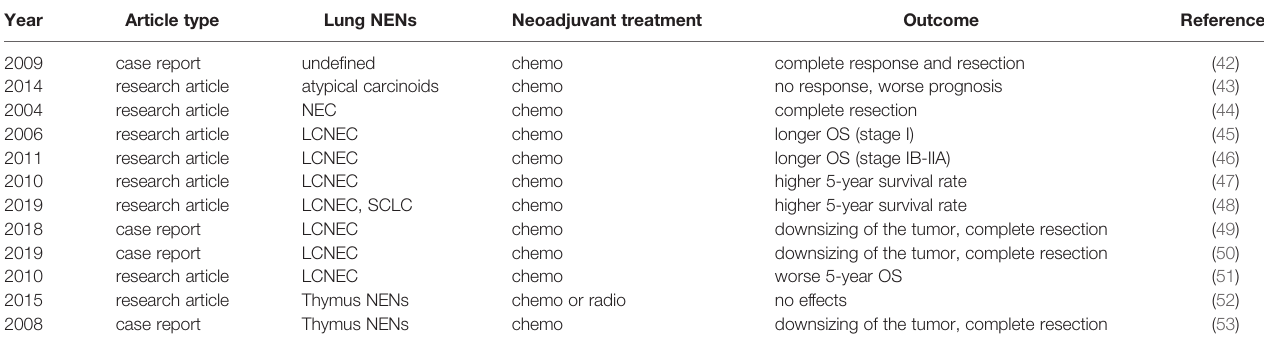
TABLE 2 | Neoadjuvant therapies in lung